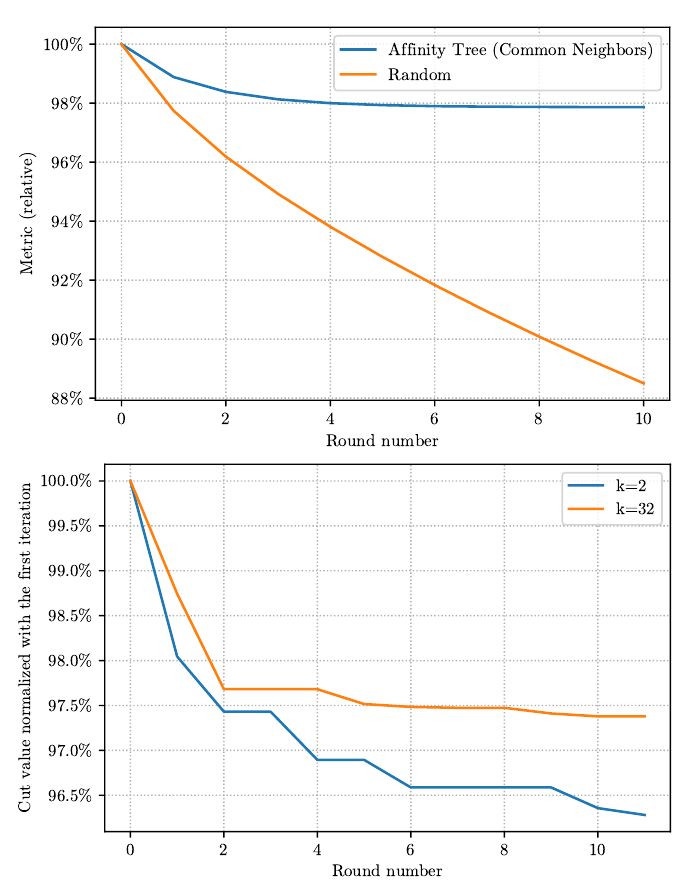
Figure 9. Convergence rate of Aff+Metric ( top ) and Aff+Swap ( bottom ) on World-roads .